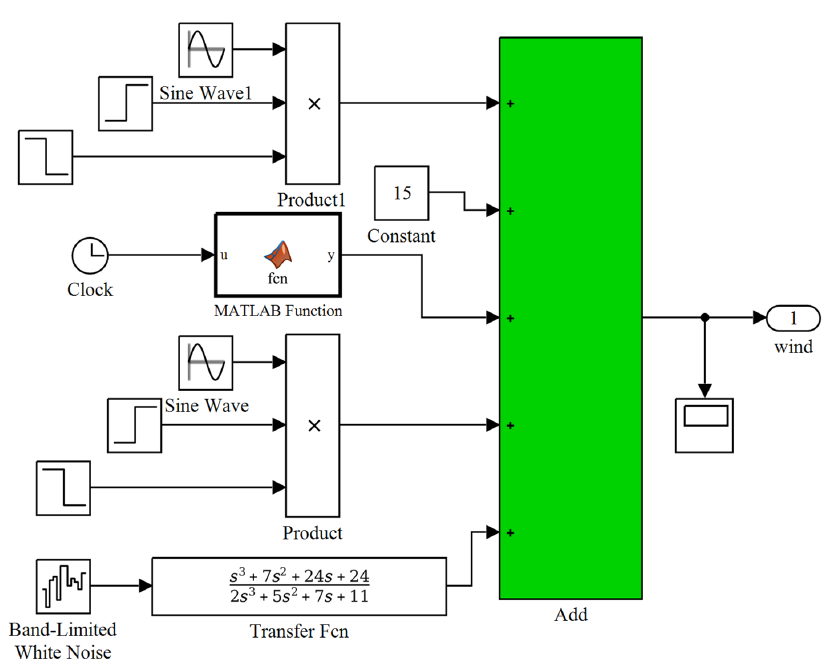
Figure 6. Model of resultant wind speed, representing the basis wind, gradient wind, gusty wind, and random wind.